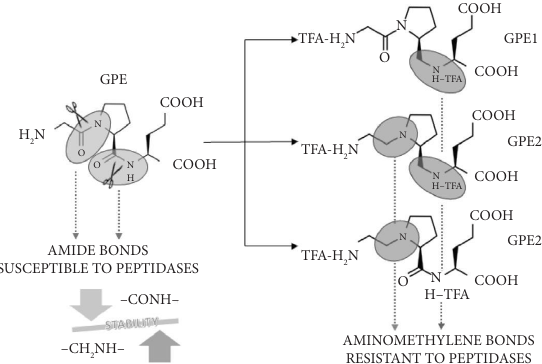
Figure 1: Te examined GPEs peptidomimetics synthesized from natural